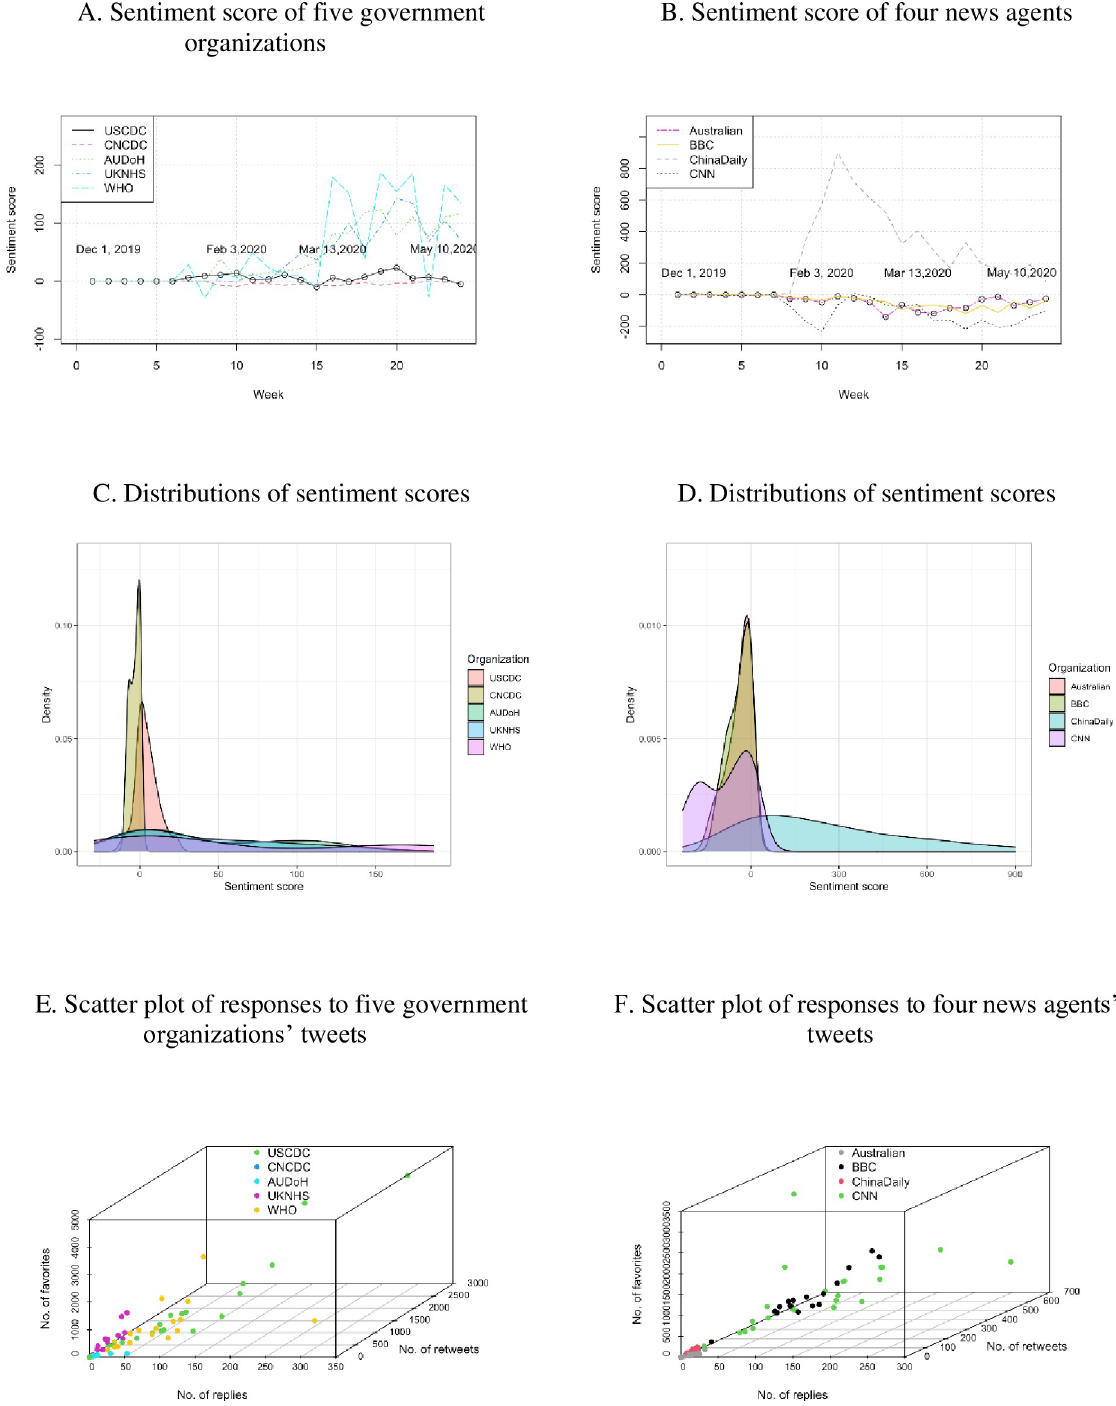
Fig 3. Sentiment score, their density and scatter plots of responses to nine organizations’ weekly tweets.